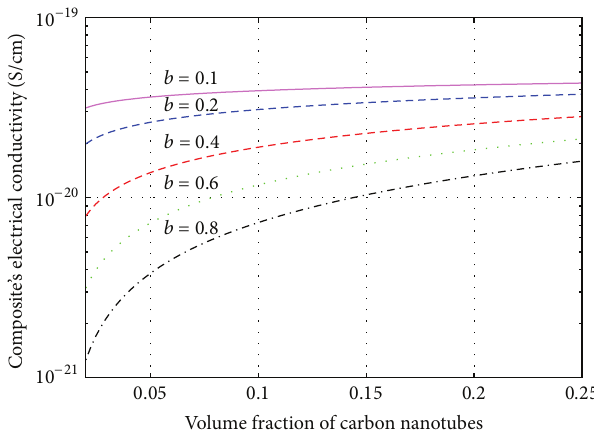
Figure 1: Dependence of electrical conductivity on filler volume fraction.